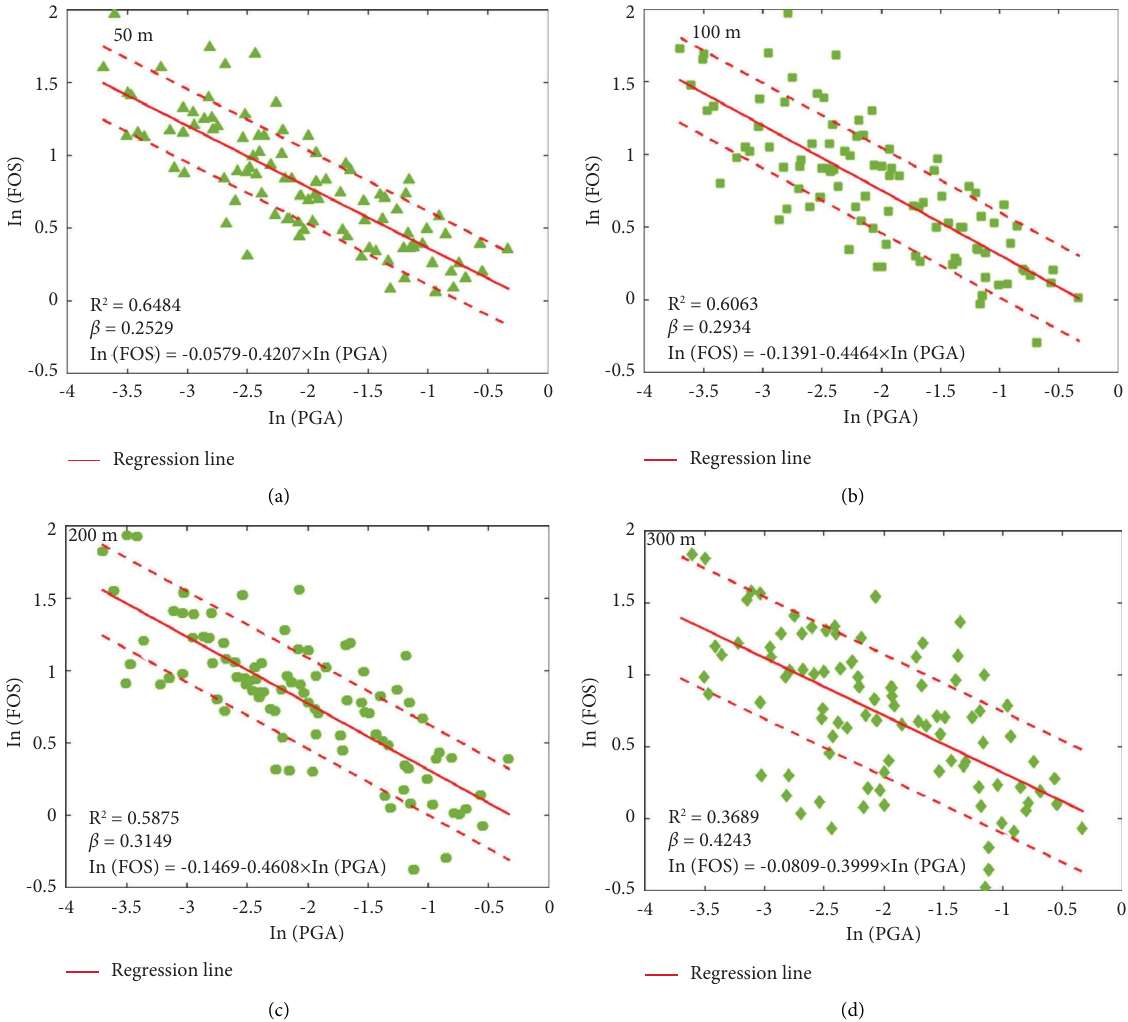
Figure 7: PSDM of FOS with respect to PGA for the open-pit slopes with diferent mining depths. (a) 50m. (b) 100m. (c) 200m. (d) 300m.